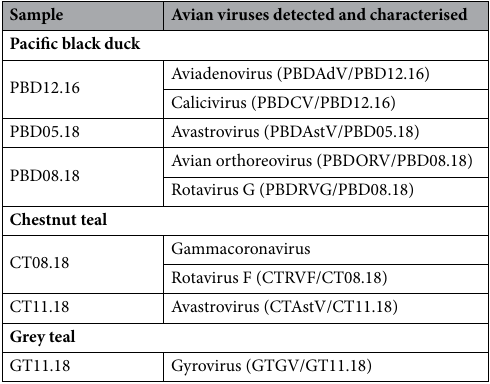
Table 1. Avian viruses detected and characterised from the duck samples. A total of nine viruses were characterised from the duck samples, of which eight of them are described in the current study in detail. Viruses characterised previously from these duck samples are published earlier 1,3,4,6